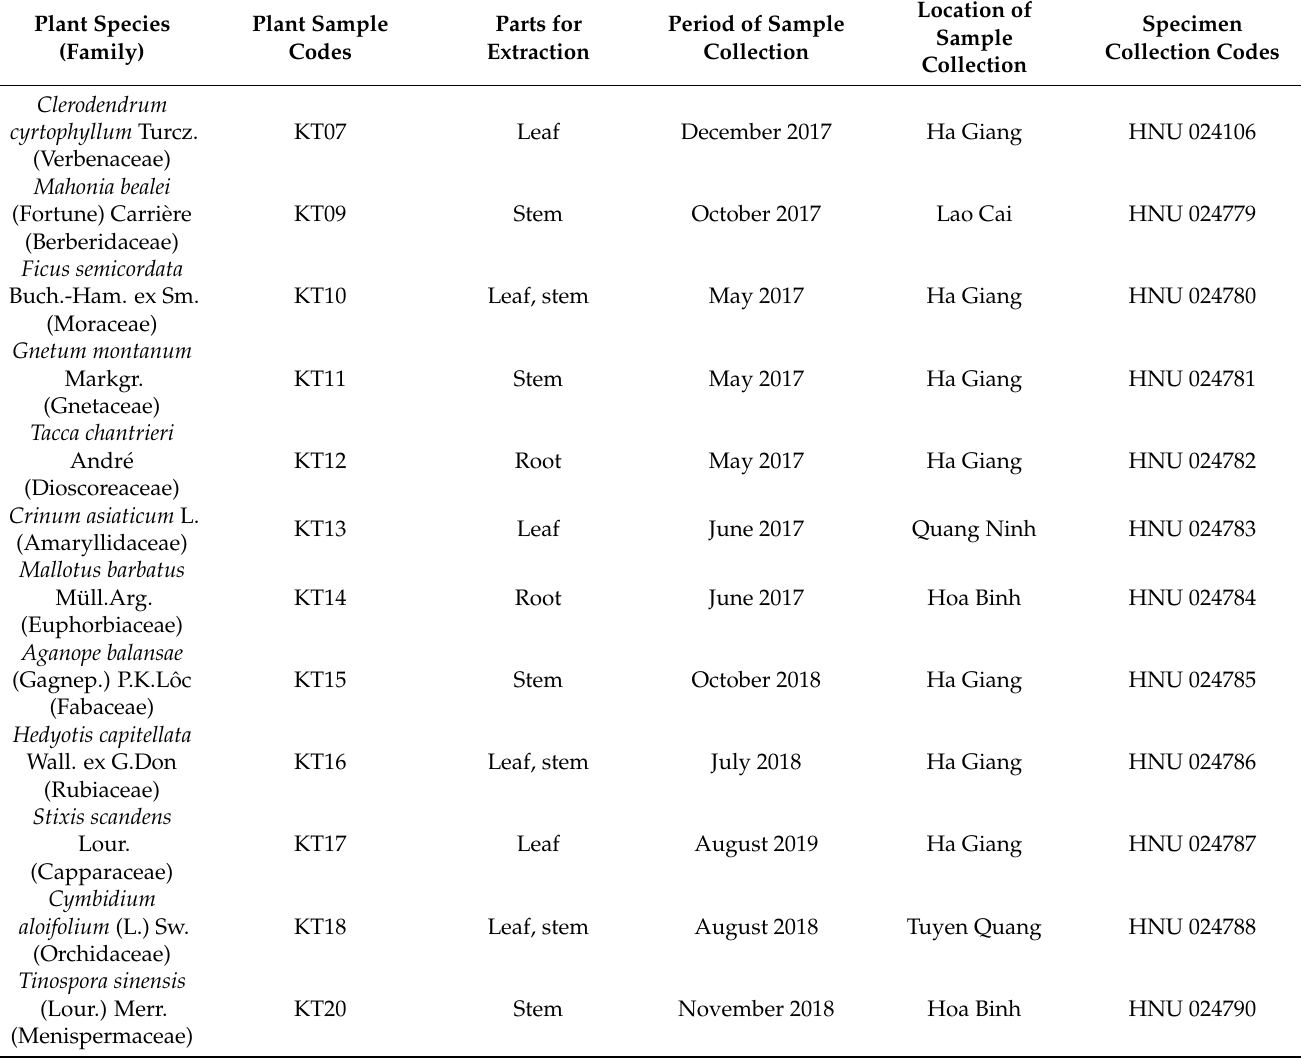
Table 1. Medicinal plants used in this